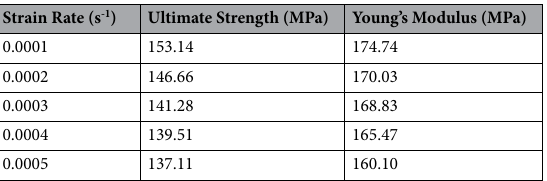
Table 2. The BAG’s mechanical properties function strain rate in the deformation test process.